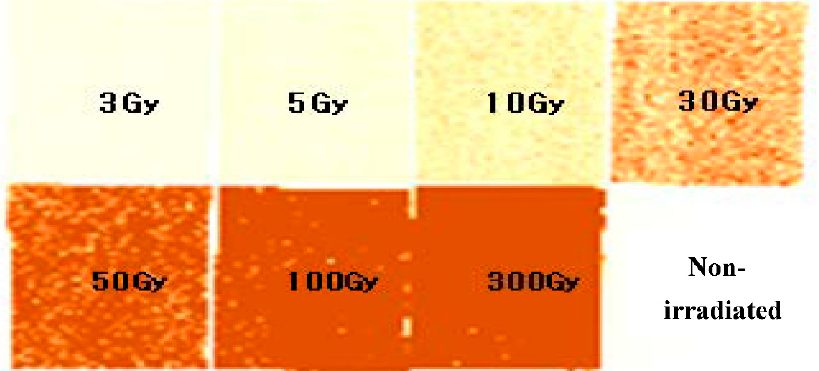
Figure 5. RPL emission image of sheet-type Ag + -doped phosphate glass which is irradiated with homogeneous gamma-rays in the range from 3 [Gy] to 300